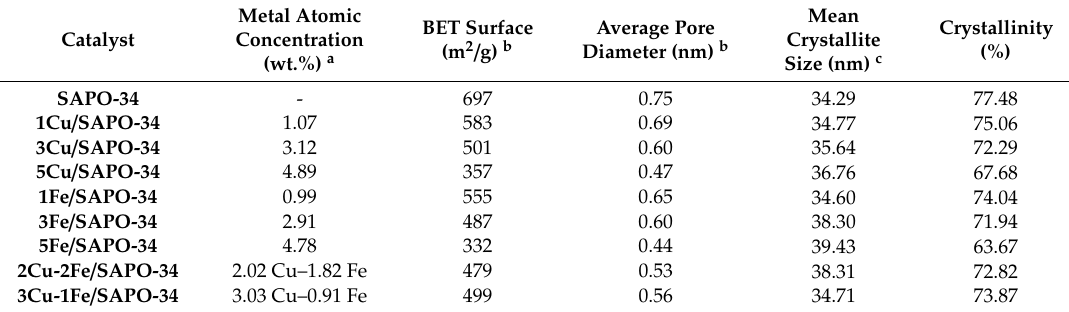
Table 1. Physicochemical properties and crystallinity of the as-synthesized